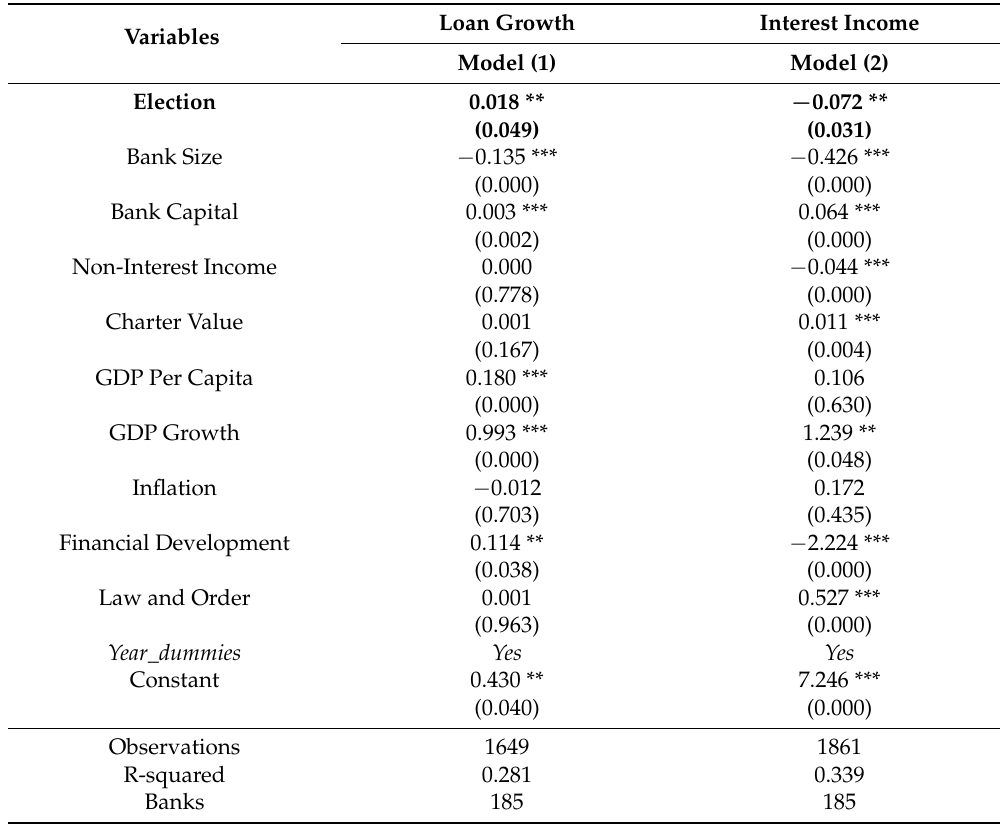
Table 4. Political pressure on state-owned